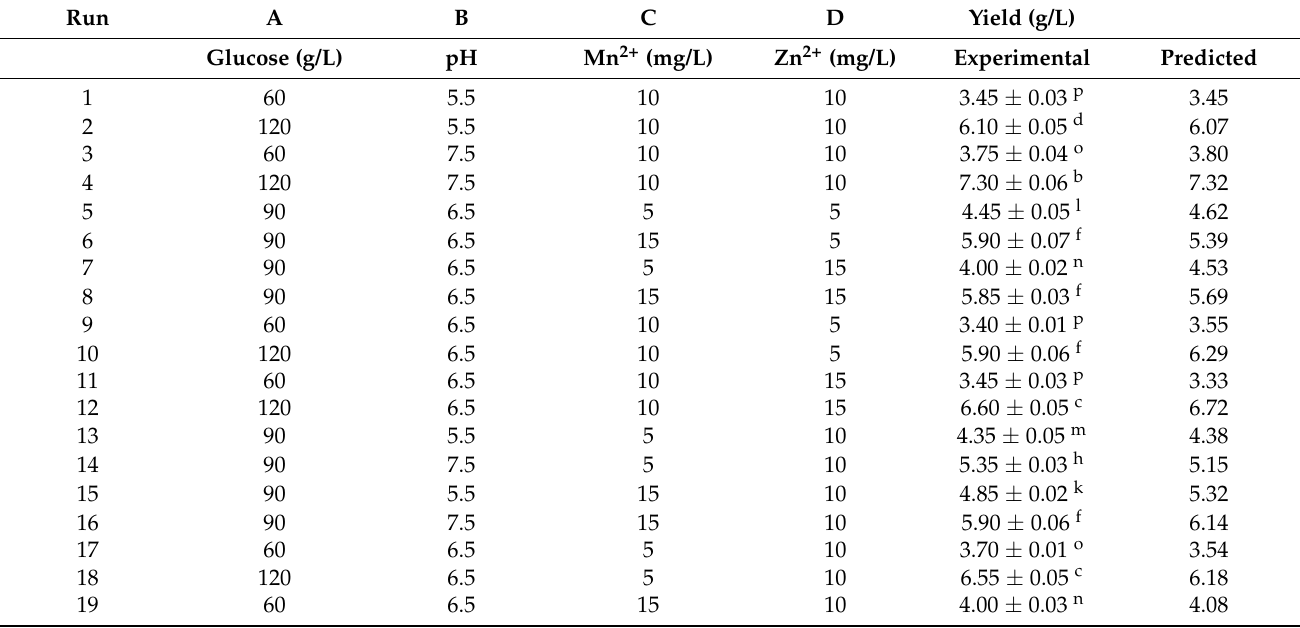
Table 2. The Box–Behnken design and corresponding observed values.